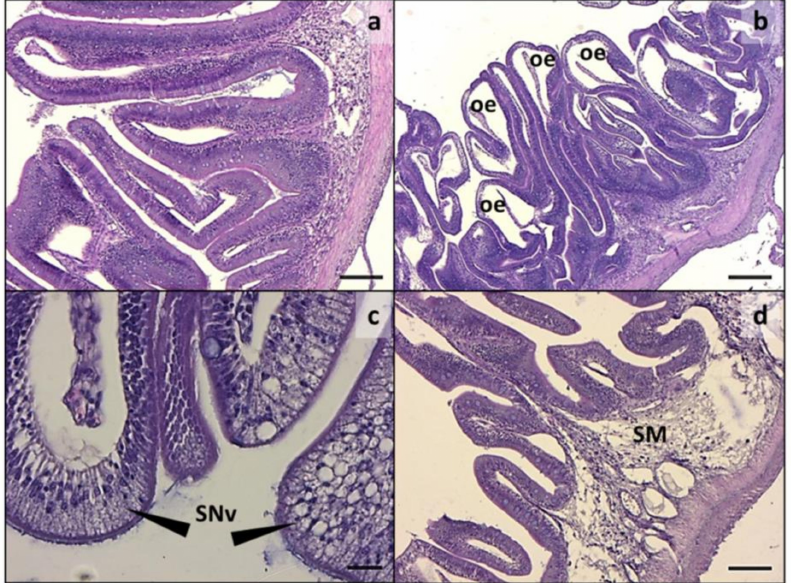
Figure 1. Medium intestine. ( a ) Normal histology from CF; ( b ) histological architecture alteration, including oedema and severe folds fusion degree in CV; ( c ) high magnification showing enterocyte ipervacuolization in CV; ( d ) highly infiltrated and vacuolated submucosa in CV group. oe: oedema; SNv: supranuclear vacuoles; SM: submucosa. Scale: a , d = 100 µ m; b = 200 µ m; c = 20 µ m.